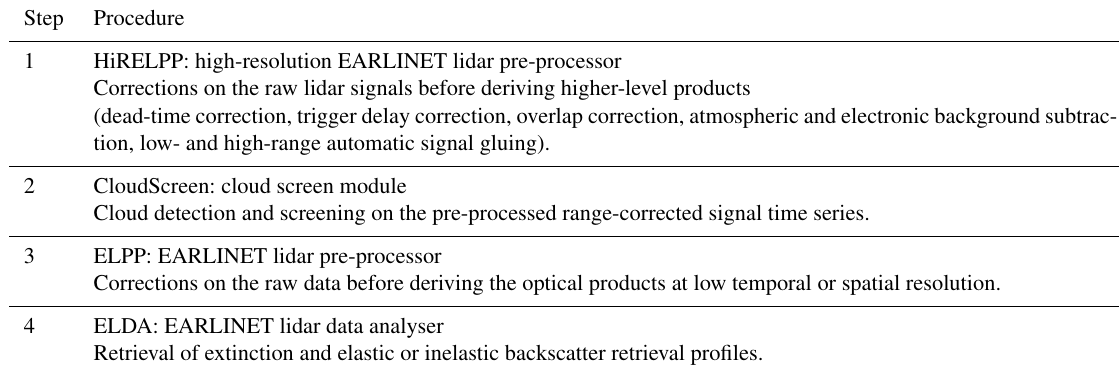
Table 2. QA procedures applied to EARLINET lidar